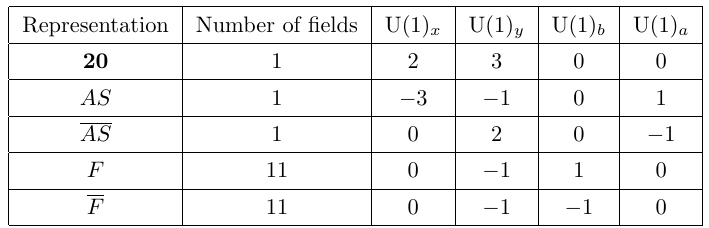
Table 32 . Matter content and assigned charges for an SU(6) gauge